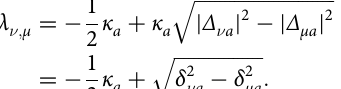
Fig. 4 Eckhaus instability ladder for high laser power. a Ladder of Eckhaus instabilities for high powers. Numerically computed, Eq. (4), spectra of the optical parametric oscillator (OPO) signal vs pump detuning, δ 0 b , for the pump laser power W ¼ 3 mW (4.8d Bm) and ε 0 = 5 κ b , see the horizontal white dashed line in Fig. 2a. The white vertical dashed lines map the sequence of the Eckhaus instability thresholds, λ ν , ν ±1 = 0, see Eqs. (22) and (23). The colour scale shows the sideband power in dBm. b – d show the details of the spectra of the pump (green) and OPO signal (red) corresponding to the dashed green lines in ( a ). Spectra in ( c ) and ( d ) are the staggered combs. d corresponds to the non-degenerate OPO state that is very well approximated by Eq. (17). The vanishing power levels have been included in ( d ) in order to demonstrate that the non-degenerate OPO states belong to the staggered comb yields a set of the sideband-pair growth rates, ffiffiffiffiffiffiffiffiffiffiffiffiffiffiffiffiffiffiffiffiffiffiffiffiffiffiffiffiffi